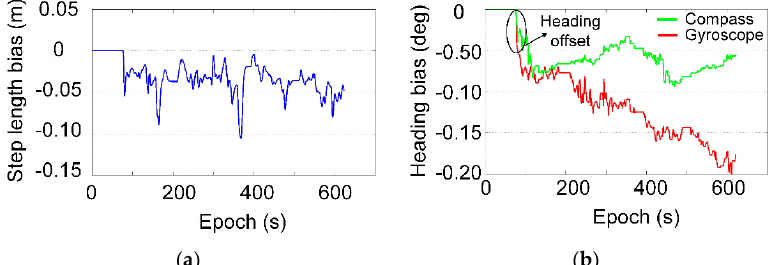
Figure 14. ( a ) is the step length bias of PDR; ( b ) is the heading bias. The step length and heading bias